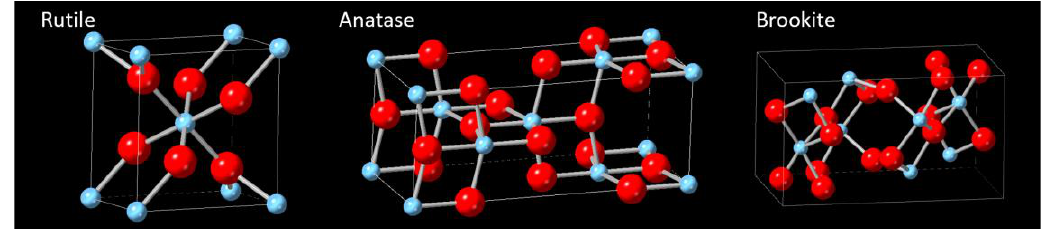
Figure 7. Crystallographic structures of TiO 2 phases. Table 3. Physical properties of TiO 2 phases.